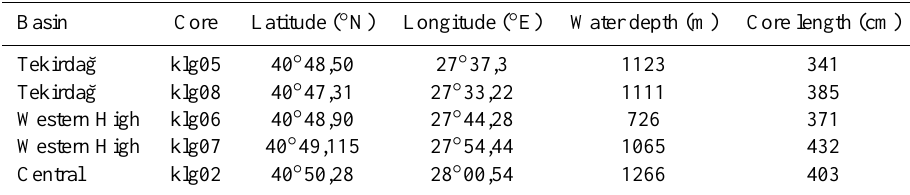
Table 1. Location of Kullenberg cores collected during the Marmascarps mission in